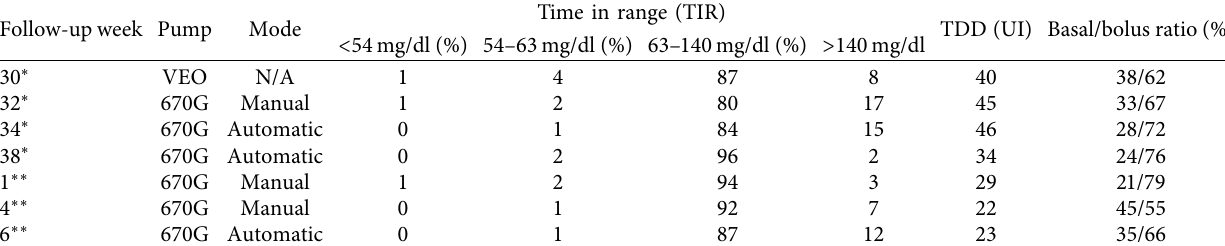
Table 1: Glycemic control